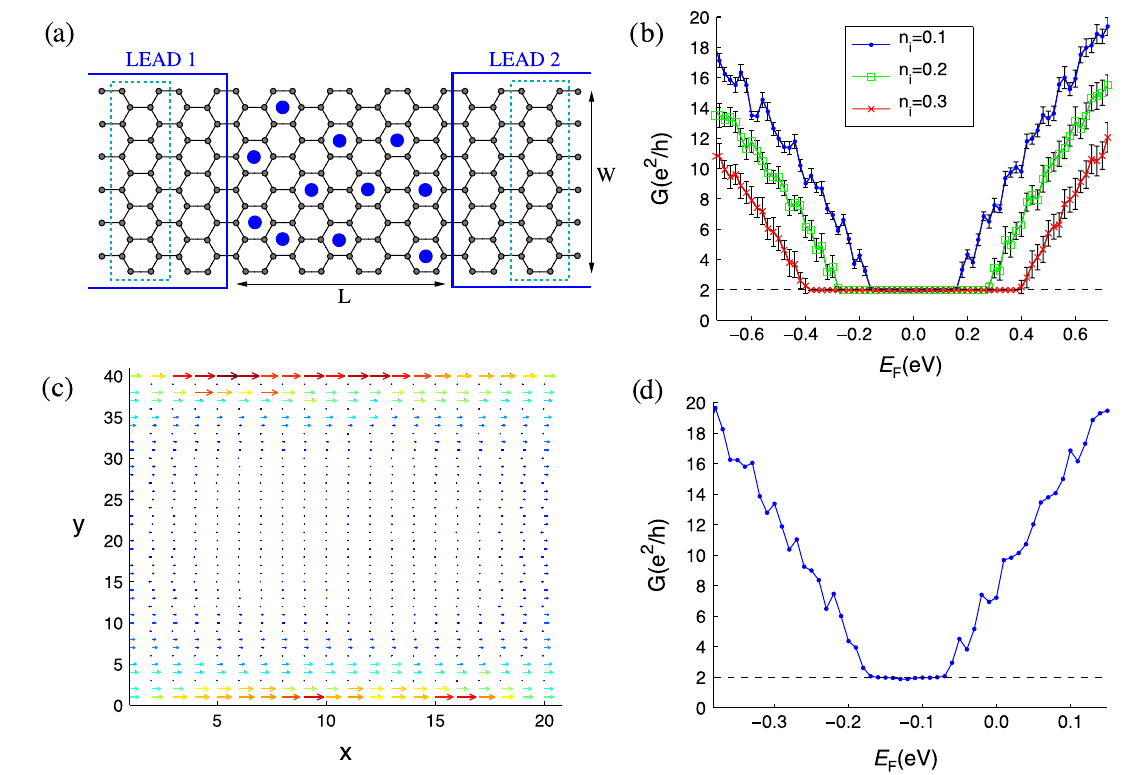
FIG. 4. Transport. (a) Configuration used to determine the two-terminal conductance. Semi-infinite clean graphene leads are connected to the sample, which has adatoms distributed randomly across it. The length L of the system is set by the number of columns (indicated by dotted lines). The width W refers to the number of sites along either edge of the figure, corresponding to the number of unit cells of an armchair nanoribbon required to create an individual column. (b) Conductance G as a function of the Fermi ¼ 0 : 1 , 0.2, 0.3 for a system of size , averaged over 40 independent random-adatom realizations at different concentrations n energy E i F ¼ 0 : 1 t . (c) Current distribution across a sample of size W ¼ 40 and L ¼ 20 at n ¼ 0 : 2 , (cid:2) ¼ 0 : 1 t and W ¼ 80 and L ¼ 40 with (cid:2) i so so ¼ 0 : 15 eV . The magnitude of the current is represented by both the arrow size and color. (d) Conductance for the largest simulated E F ¼ 0 : 02 t and (cid:5)(cid:6) ¼ 0 : 1 t ) estimated from DFT data. Here W ¼ 200 , system size using realistic parameters for thallium adatoms ( (cid:2) so ¼ 0 : 15 . In all panels we take t ¼ 2 : 7 eV L ¼ 100 , and the coverage is n i (cid:5)(cid:6) r ¼ 0 (corresponding to an otherwise clean graphene ¼ 0 . Figure 4(b) illustrates the sheet), (cid:5)(cid:6) ¼ 0 , and (cid:2) R